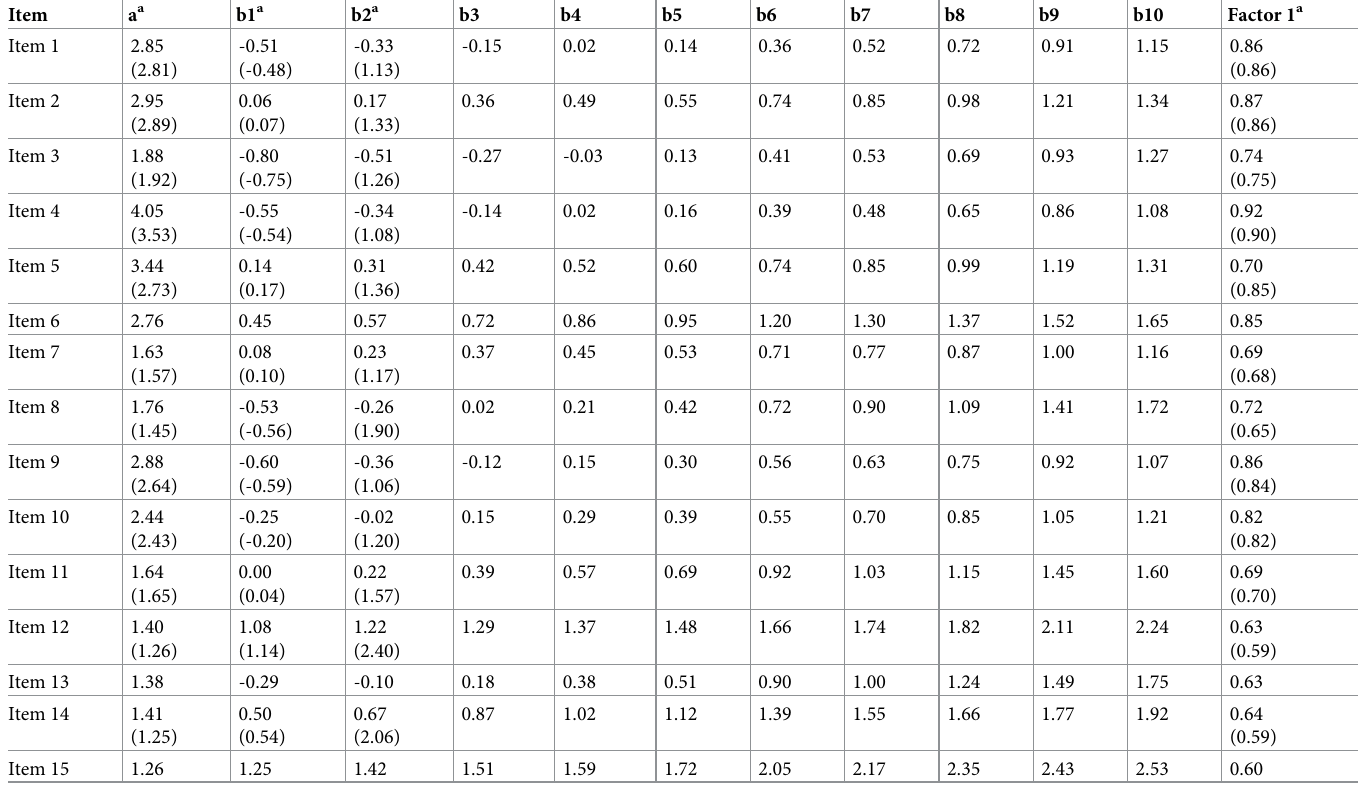
Table 3. Discrimination and difficulty parameter estimates for the ENRICh